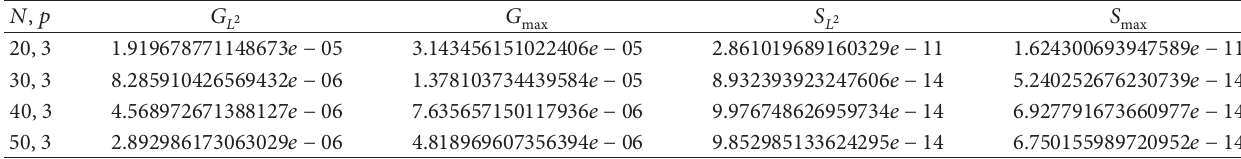
Table 2: Error values of (42) in Example